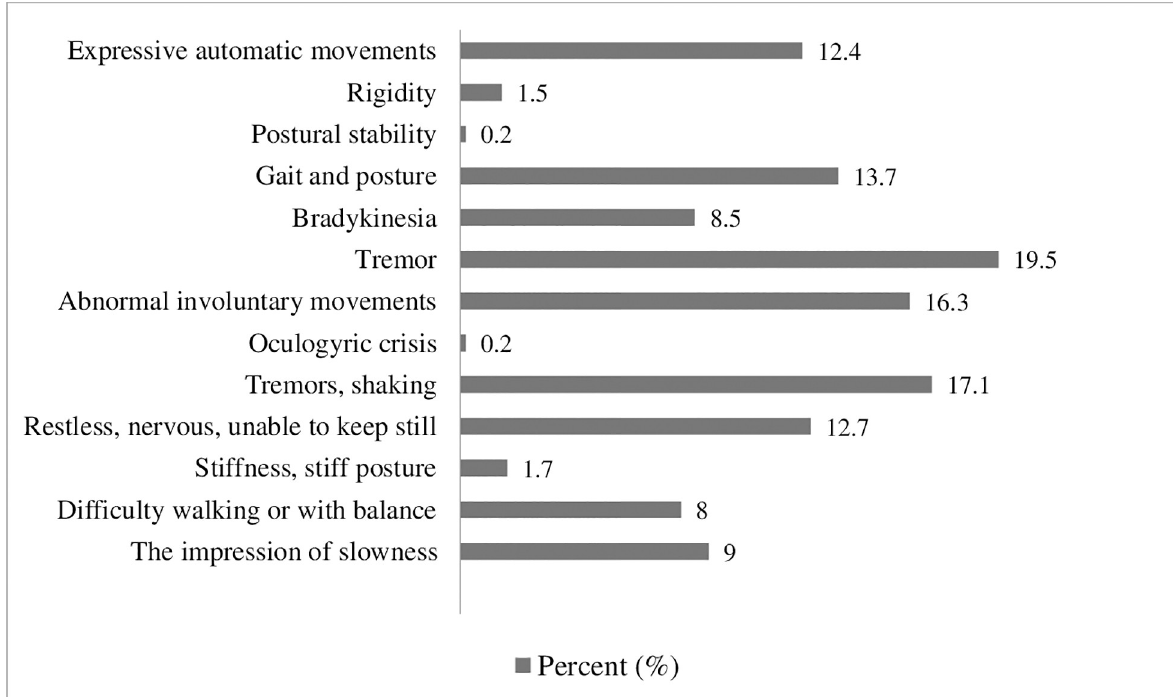
Fig 1. Percentage distribution of drug induced signs and symptoms among mentally ill patients attending follow-up treatment at JMC Psychiatry clinic, 2019.